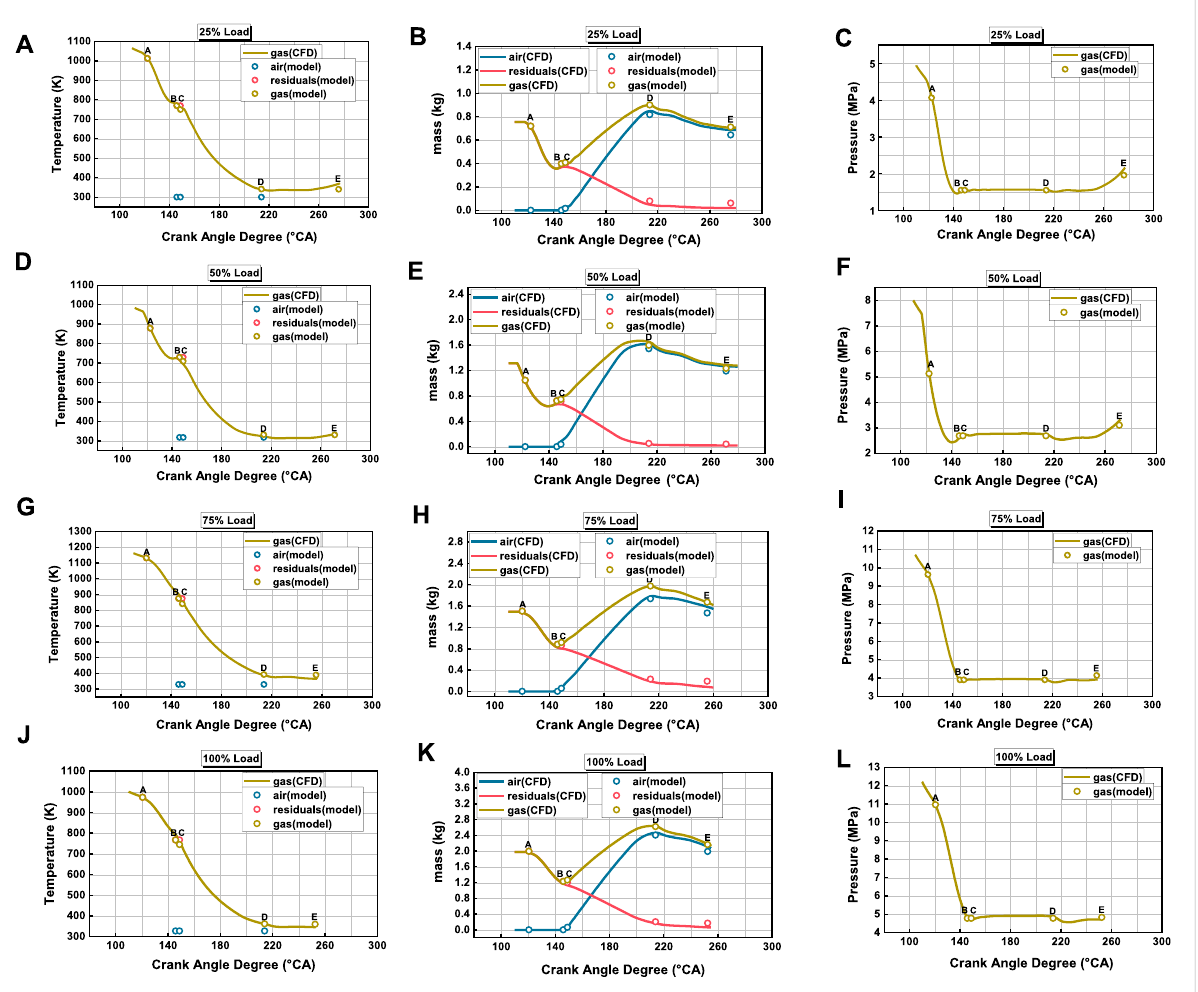
FIGURE 7 Comparison of the results of ZDMS model and CFD model for parameters such as (A) temperature, (B) mass and (C) pressure at 25% load, (D) temperature, (E) mass and (F) pressure at 50% load, (G) temperature, (H) mass and (I) pressure at 75% load, and (J) temperature, (K) mass and (L) pressure at 100%